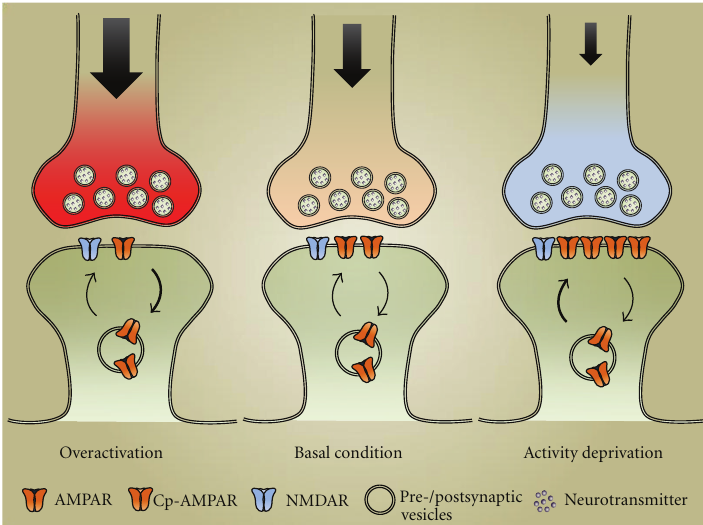
Figure 2: Activity-dependent homeostatic regulation of AMPAR synaptic localization. Under basal conditions, a stable level of AMPARs at postsynaptic surface is maintained by balanced tra ffi cking processes of receptor insertion and internalization (middle). High synaptic activity can be detected by neurons, leading to enhanced receptor internalization and reduced surface receptor localization (left). Conversely, when neurons are treated by long-term activity deprivation, higher levels of AMPARs are expressed at postsynaptic surface via enhanced receptor insertion, including both GluA2-containing and GluA2-lacking receptors (Cp-AMPAR) (right). During homeostatic regulation, the number of NMDARs at postsynaptic surface is not significantly altered under either